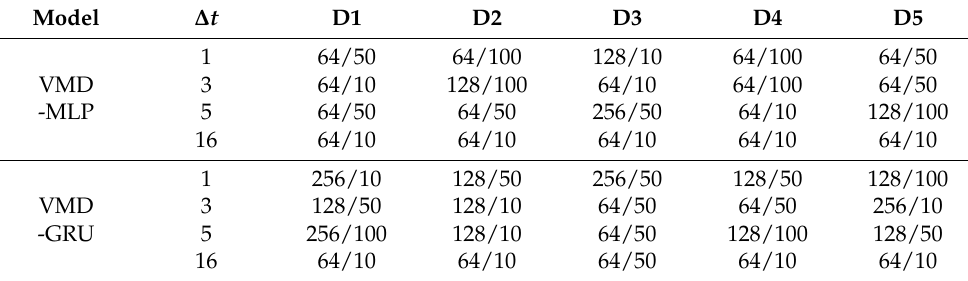
Table 5. The final tuning of hyperparameters (NHN/NI) of the three forecasting models under different time